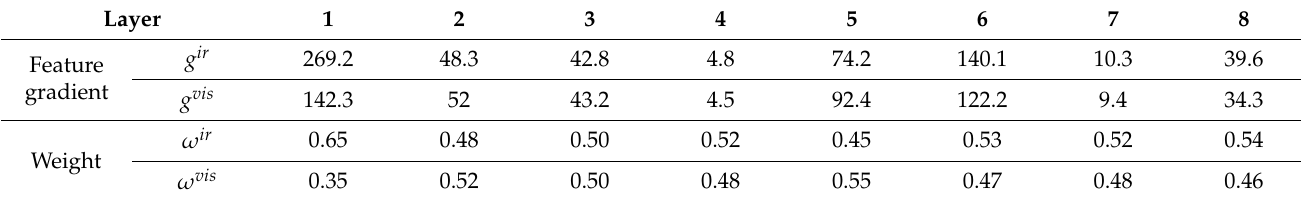
Table 1. The feature gradient and weight of the first eight